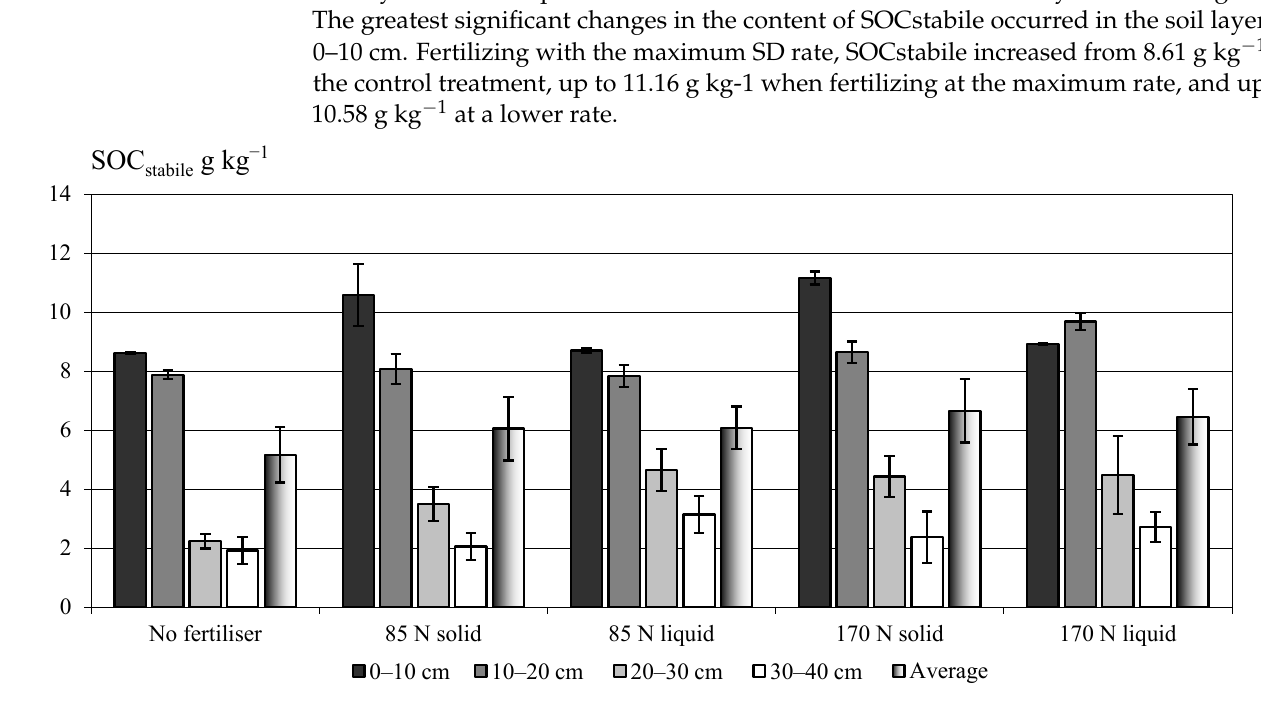
Figure 2. Stabile soil organic carbon (SOCstabile) in crop rotation field treated by digestate, 2019. Vertical bars represent standard error.